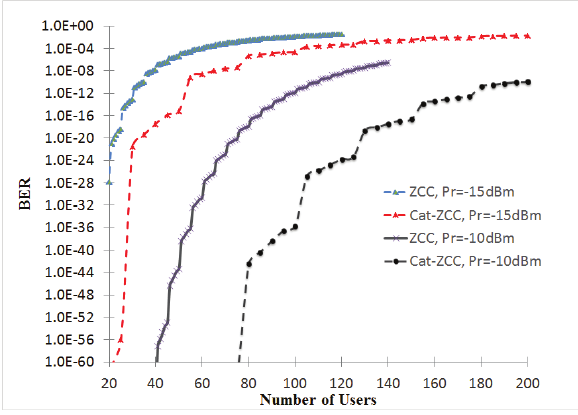
Fig. 3. Comparison of number of users for catenated- OFDM/OCDMA-ZCC with conventional